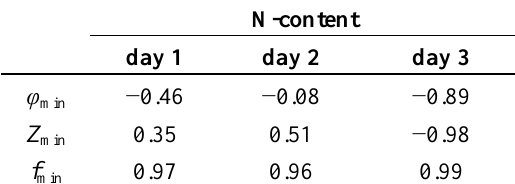
, Z , and f variable behavior vs. N-content: Pearson min min min , Z , and f variables vs. N-content min min min